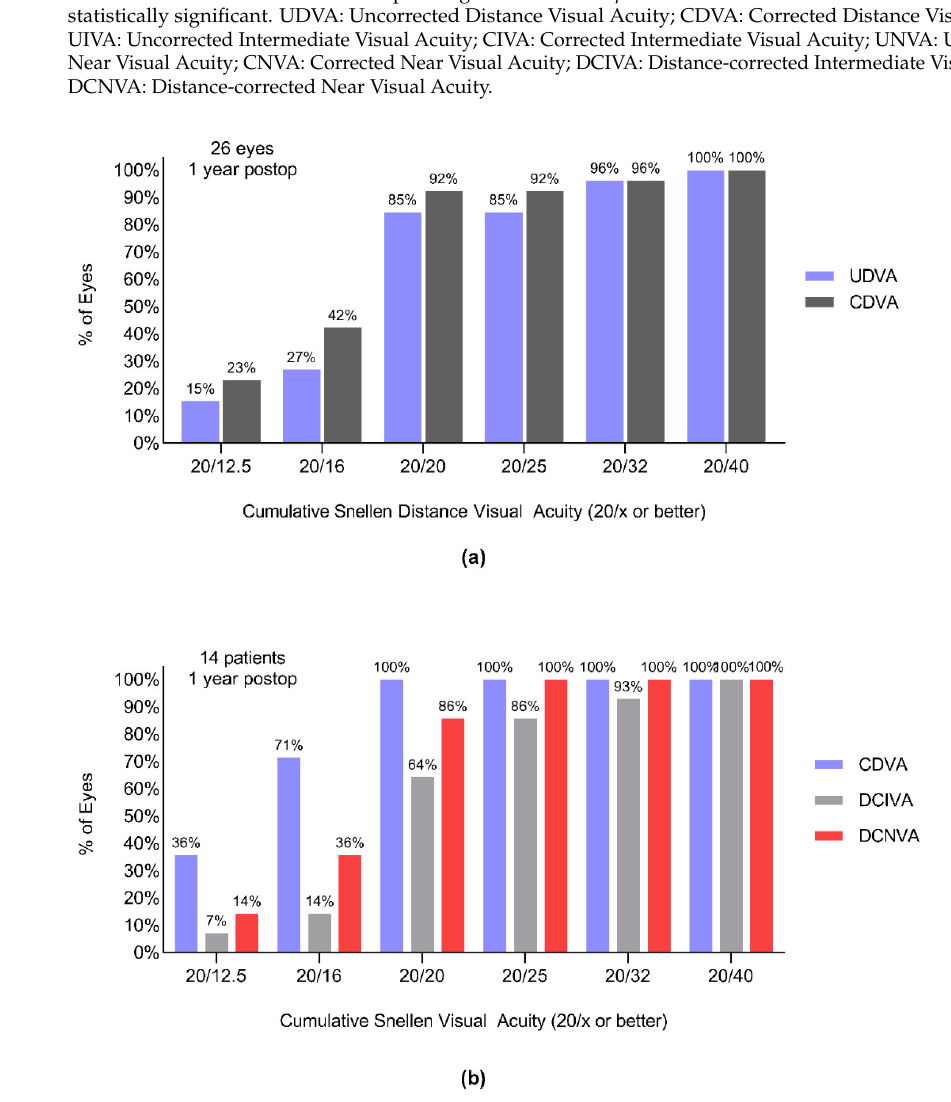
Figure 4. ( a ) Cumulative histogram of monocular uncorrected and corrected distance visual acuity. ( b ) Cumulative histogram of binocular distance-corrected visual acuities at multiple distances measured 1 year postoperatively. Binocular visual acuity defocus curves were maintained during the one-year follow- up (Figure 5a). During the last visit, the mean VAs were 0.1 logMAR or better from +1.75 D to − 3.25 D defocus (5.0 D wide defocus range). Contrast sensitivity defocus curves, which are reported to be more precise in reflecting small changes in optical quality than VA [15,16], show a non-significant improvement in the far and intermediate ranges between the third and twelfth postoperative months (Figure 5b).